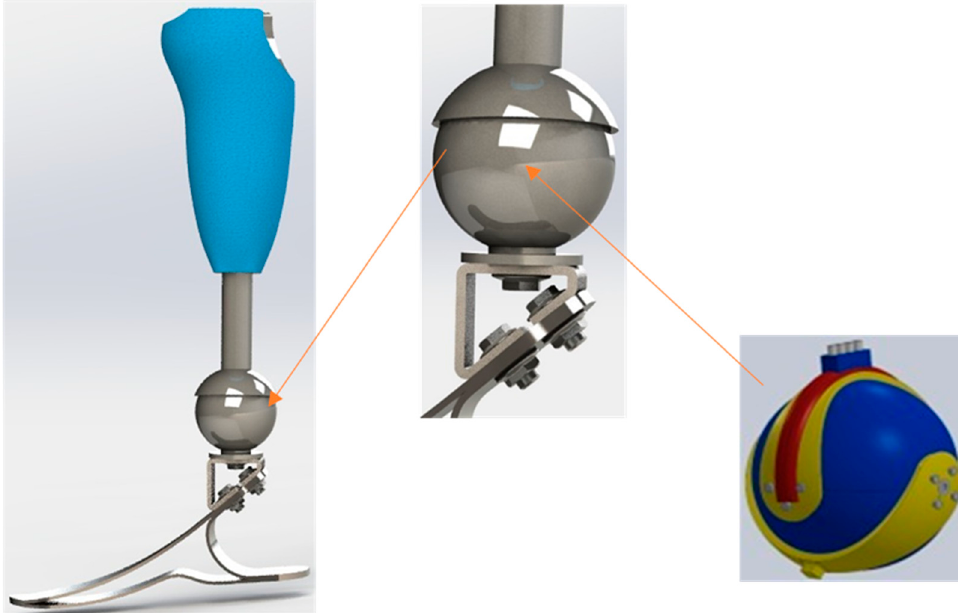
Figure 1. Ankle prosthesis with smart fluid joint.